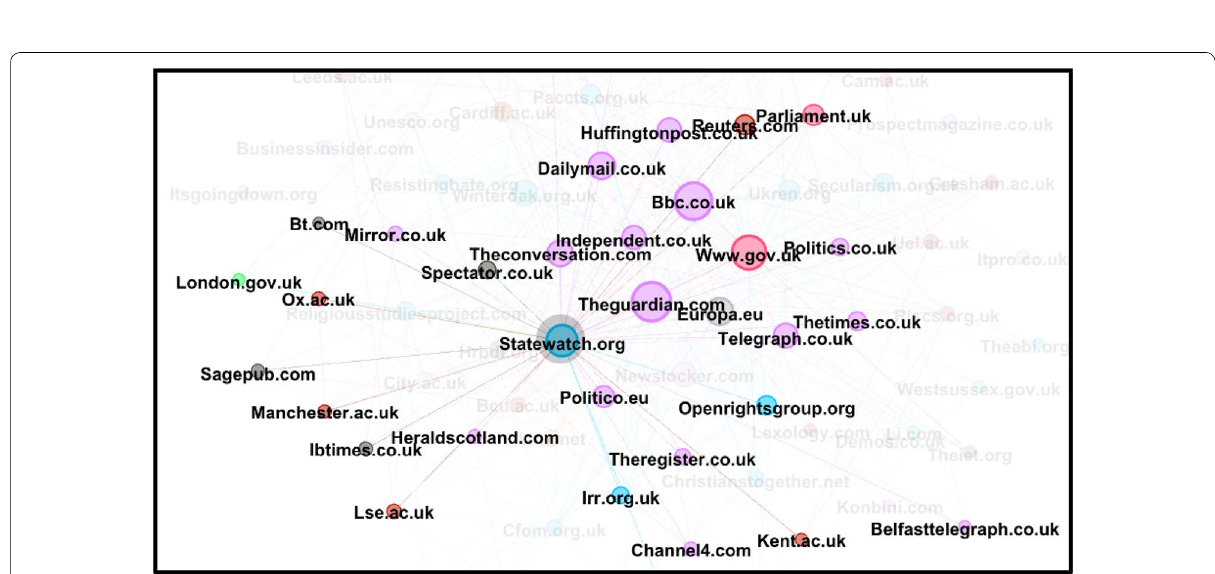
Fig. 3 NGOs are very central actors (blue